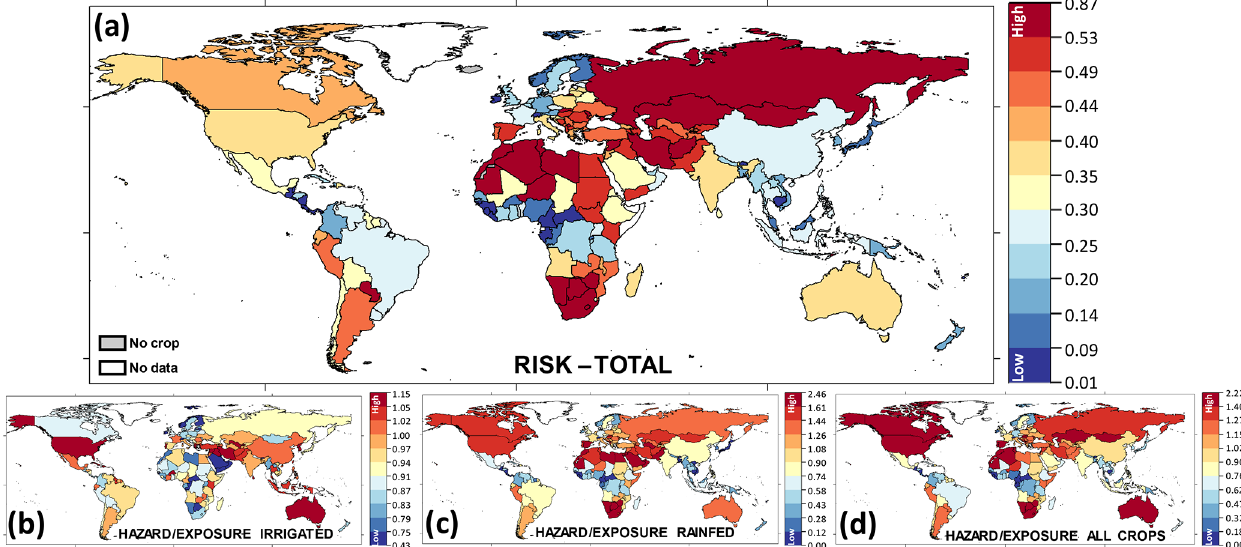
Figure 4. Drought risk (a) , hazard and exposure of irrigated crops (b) , rainfed crops (c) and the whole crop production sector (d) . The legends were defined by assigning the median of the value distribution to the yellow color in the center, the 90th percentile to the deepest red color and the 10th percentile to the deepest blue color and by determining the class ranges of the other colors by linear interpolation. Risk was calculated by multiplying hazard and exposure by vulnerability, as shown in Figs. 2c and